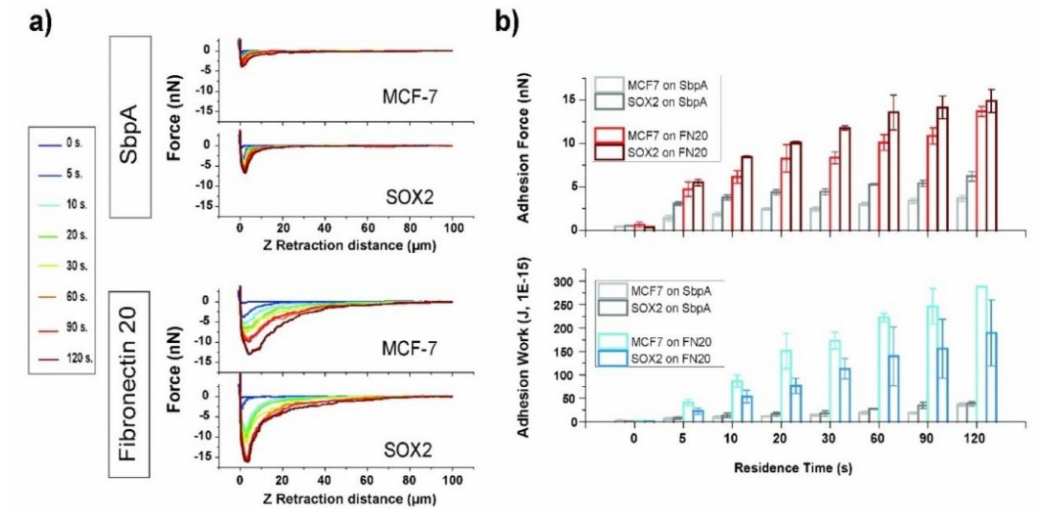
Figure 2. Cell–substrate interactions. ( a ) The resulting force–distance plots for the two cell types when placed in contact with the corresponding substrate (SbpA vs. fibronectin). ( b ) The column plots obtained for adhesion force (in nN) and the work of adhesion (in J, 1E-15) for the respective cases under